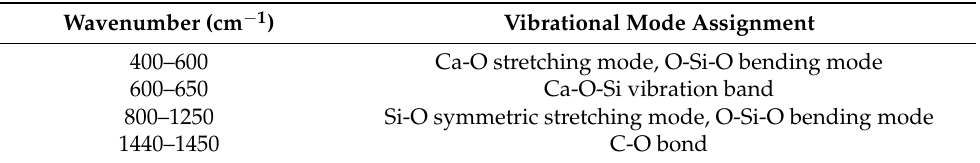
Figure 7. FTIR spectra of foam glass-ceramics 6 wt% sintered at various temperatures for 60 min. Table 3. IR absorption band and foam glass-ceramics band assignment for 1 and 6 wt% samples at various